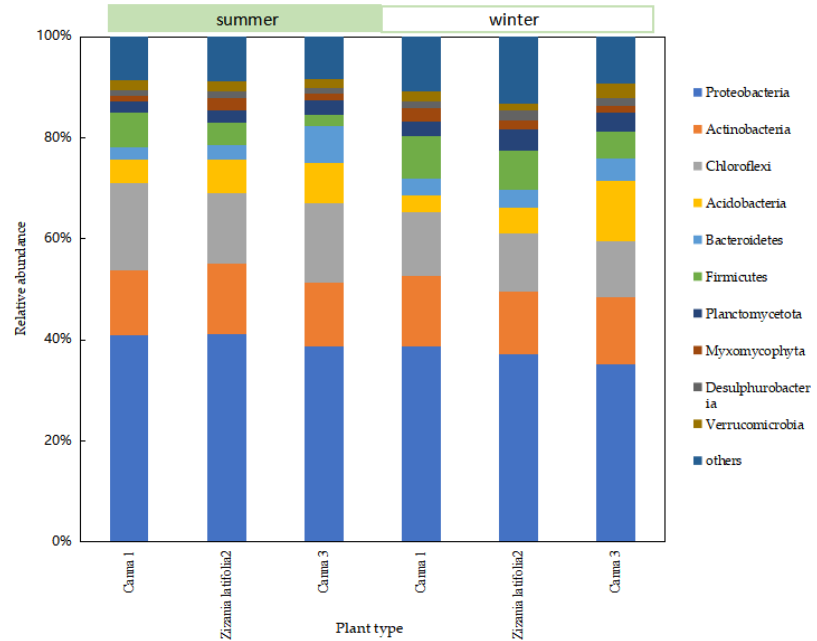
Figure 5. Relative abundance of microbial communities at the phylum level of wetland systems.